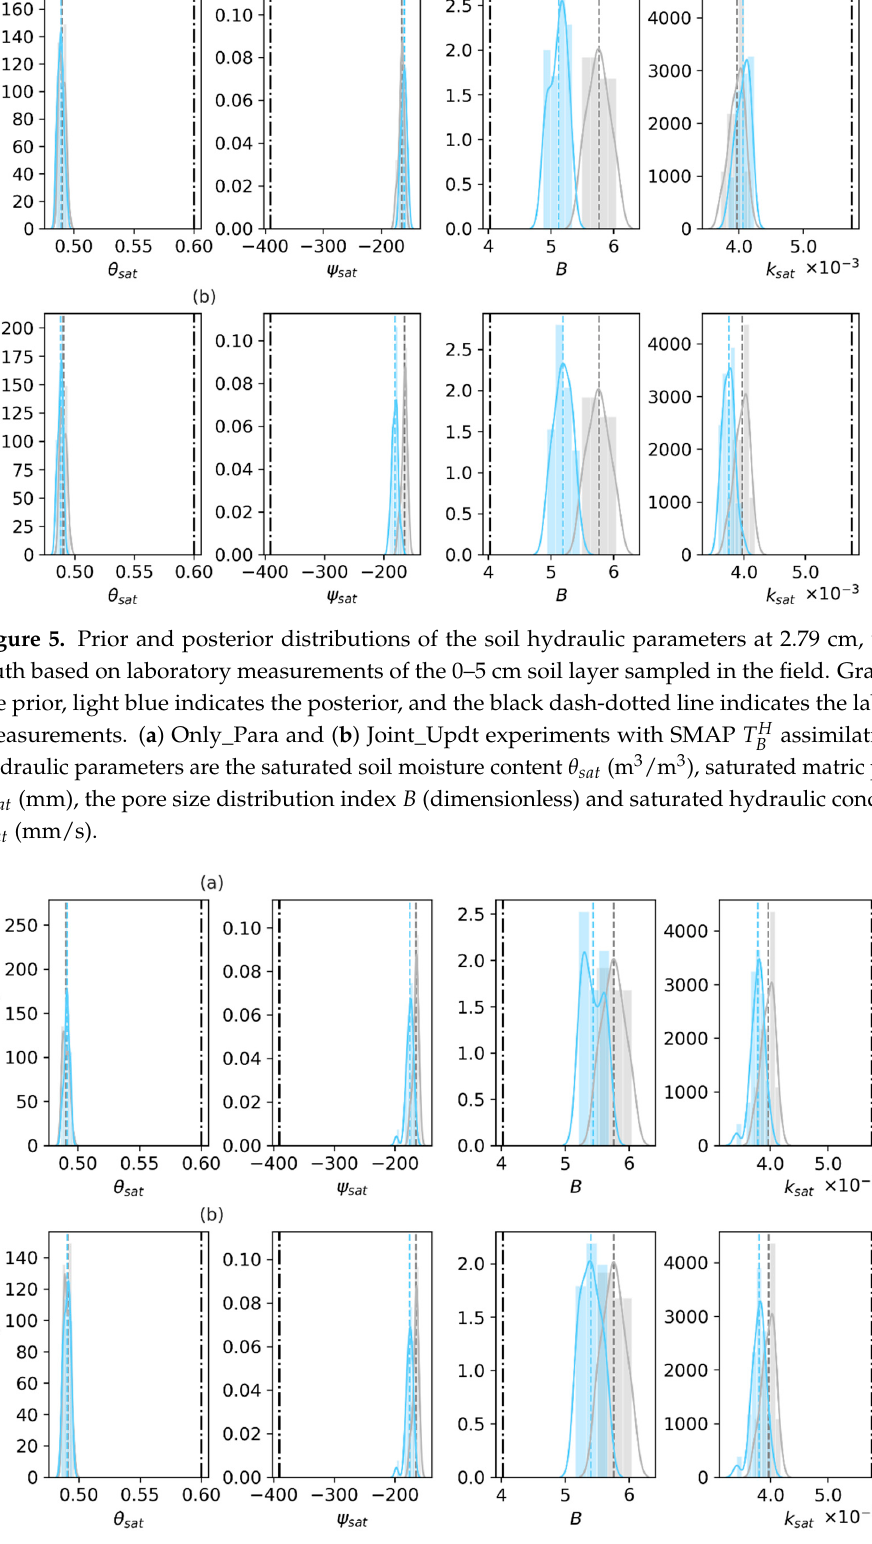
Figure 6. Same as Figure 5, but based on the experiments with SMAP T V assimilation. ( a ) Only_Para and ( b ) Joint_Updt experiments with SMAP T H assimilation. The hydraulic parameters are the saturated soil moisture content θ sat (m 3 /m 3 ), saturated matric potential ψ sat (mm), the pore size distribution index B (dimensionless) and saturated hydraulic conductivity k sat